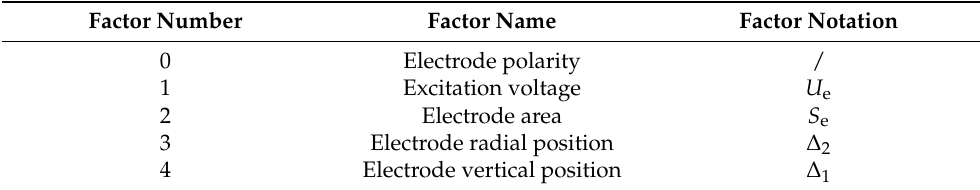
Table 2. Factors influencing the ion